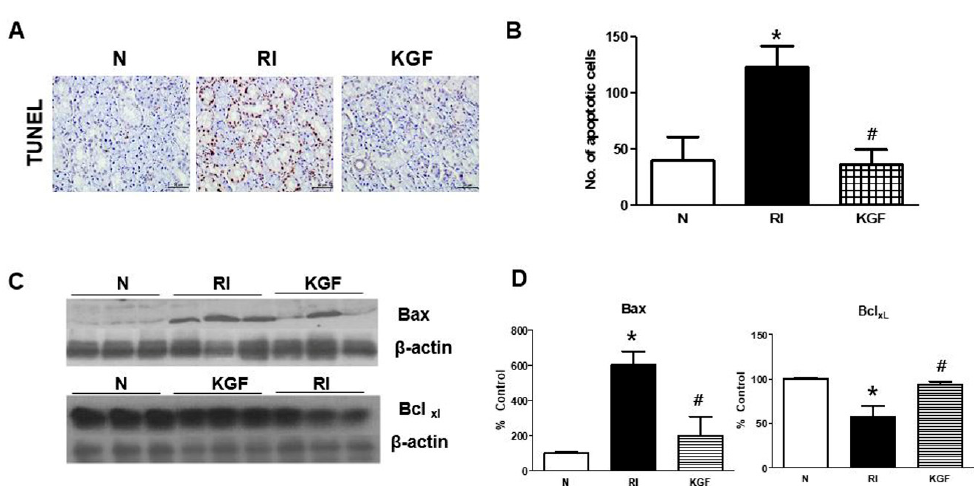
Figure 4. Effects of KGF on RI-induced apoptosis and on apoptosis-related protein expressions. ( A ) Representative TUNEL assay images. Scale bars represent 50 µm. ( B ) Quantitation of TUNEL expression showed it was greater in the RI group than in the RI + KGF-1 group. ( C ) Representative images of the expressions of apoptosis-related protein as determined by Western blotting. ( D ) Bax expression (pro-apoptotic) was higher, and Bcl expression (anti-apoptotic) was lower in the RI group than in the RI + KGF-1 group. β -Actin was used as the loading control. Results are presented as means ± SDs; *, vs. treatment naïve controls; # , vs. the RI group. * p < 0.05, # p < 0.05 ( n = 6 mice per group) (N; treatment naïve control group, RI; RI group, KGF; RI + KGF-1 group).